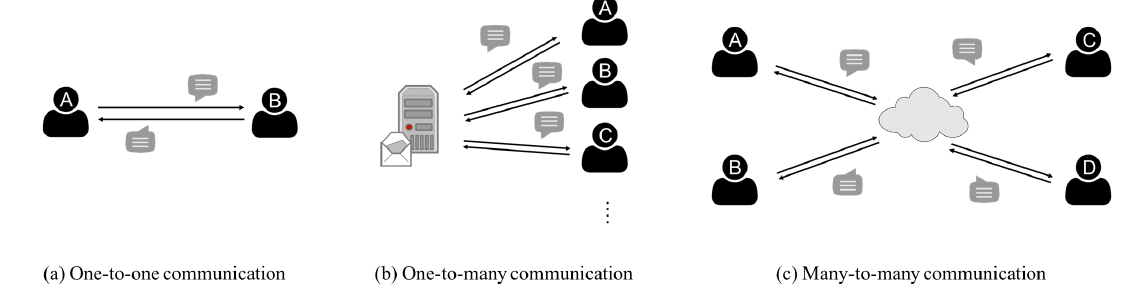
Figure 1. Three types of cloud